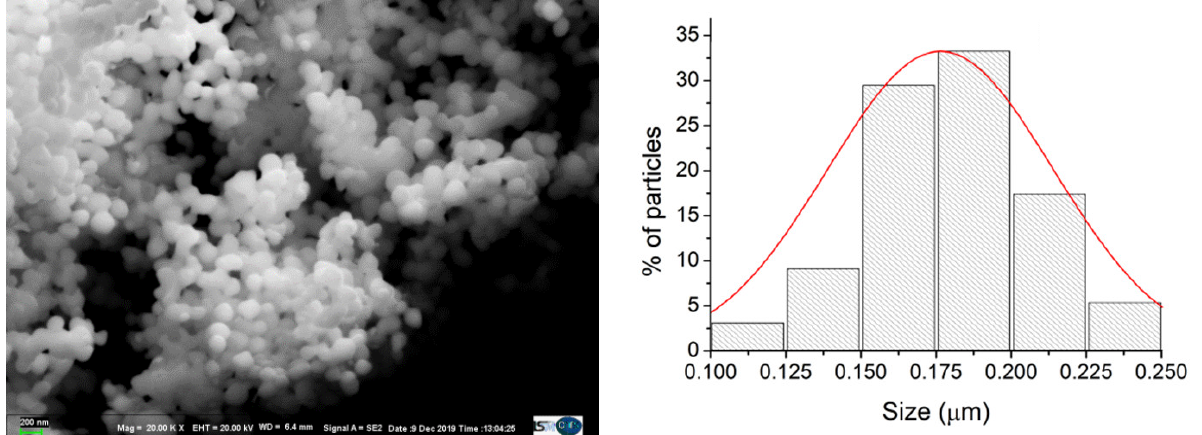
Figure 2. SEM photo and particle size distribution of Ag 5 Sn 0.9 particles.